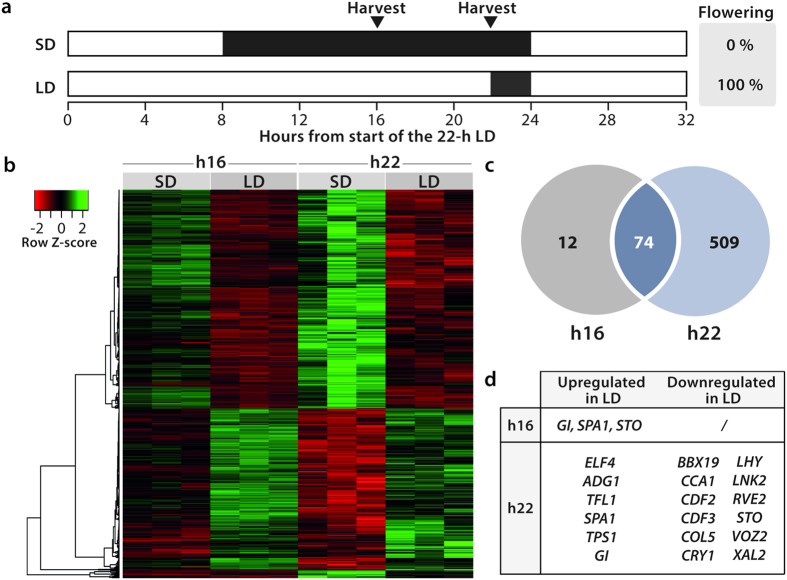
Root transcriptome changes during the induction of flowering by a single 22-h LD.(a) Experimental design. The proportion of plants having initiated flower buds two weeks after the experiment are shown on the right. (b) Heatmap of the differentially expressed genes (adjusted p-value ≤0.01; fold-change ≥2) showing three independent biological replicates per condition. Low expression levels in red, high expression levels in green. Relative expression values are scaled per transcript (lines). (c) Venn diagram of differentially expressed genes at both sampling time points. (d) List of differentially expressed flowering-time genes.